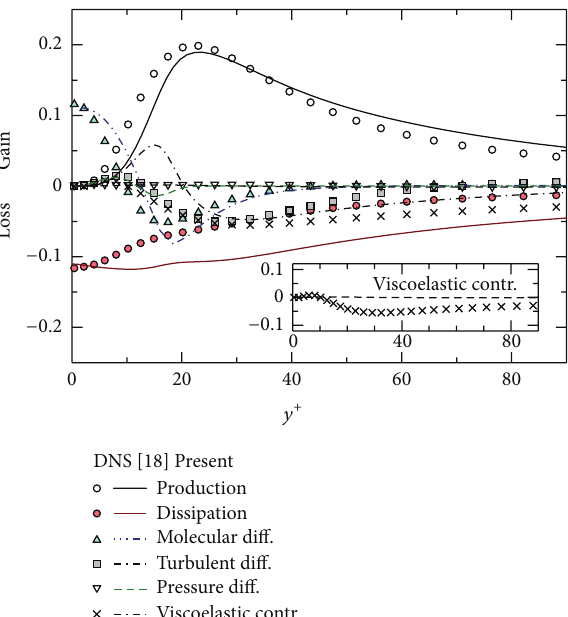
Figure 13: Budget of turbulent kinetic energy for drag-reducing viscoelastic fluid in turbulent channel flow at Re 𝜏 = 395 , Wi 𝜏 = 30 , and 𝛽 = 0.5